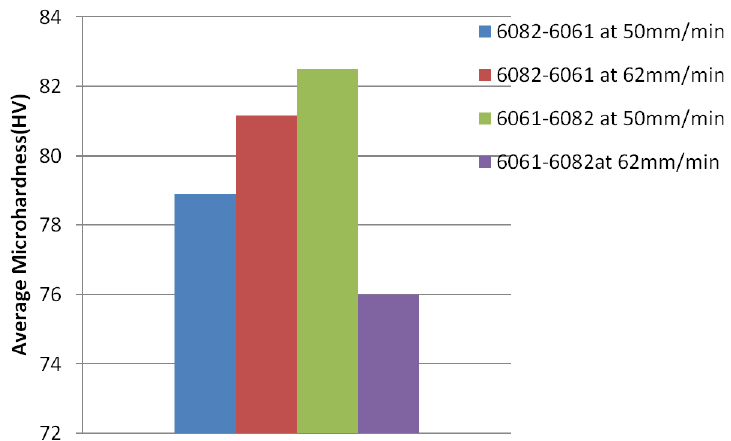
Figure 5: Effect of welding speed on microhardness for dissimilar alloys 6082-6061